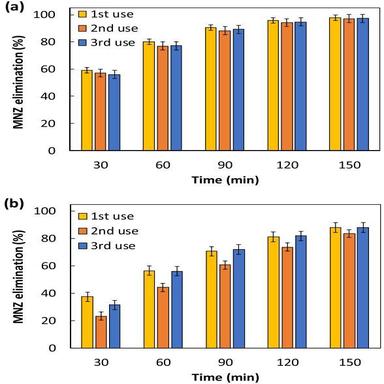
Evaluation of the cathodes reusability after three consecutive cycles for the heterogeneous EF treatment with cathodes CQ (a) and CB (b) prepared by the "pre" methodology.